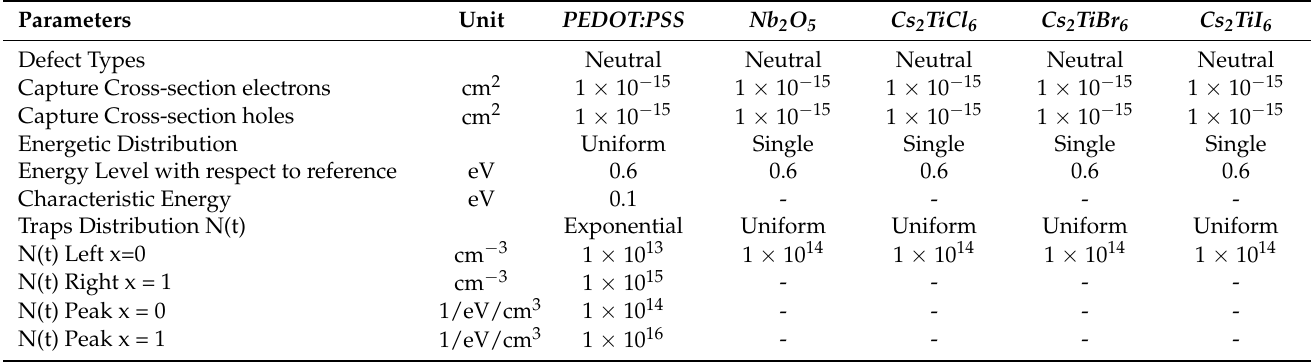
Table 2. The defect parameters for active perovskite layers, a hole-transport layer, and an electron- transport layer are considered in the simulation by SCAPS